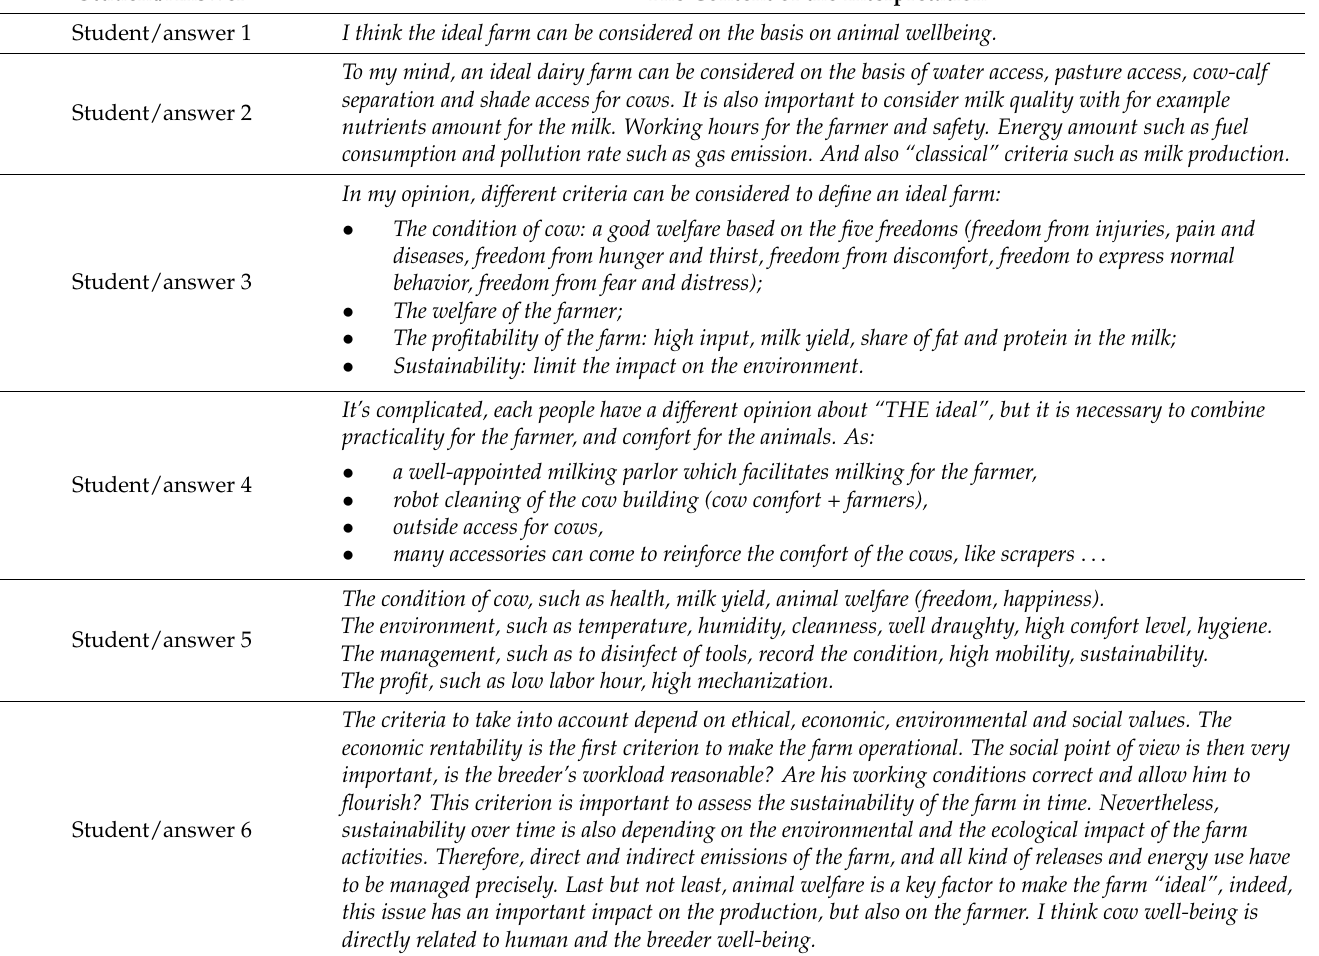
Table 3. Student answers to the question: On the basis of what criteria can the ideal dairy farm be considered? Student/Answer The Content of the